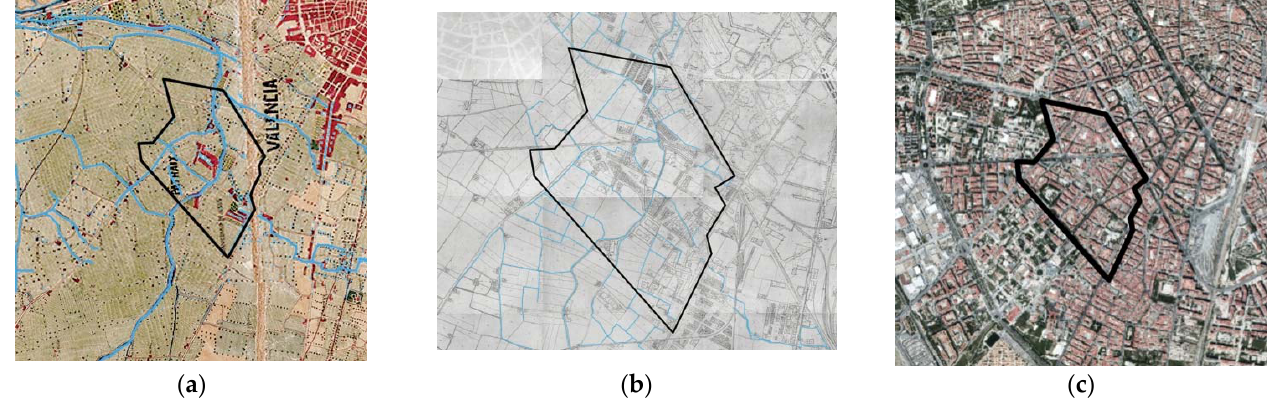
Figure 22. The neighborhood of Patraix within the cartography of 1883 ( a ), collected cadaster of 1929–1944 ( b ), satellite image of 2019 ( c ) [33–35].